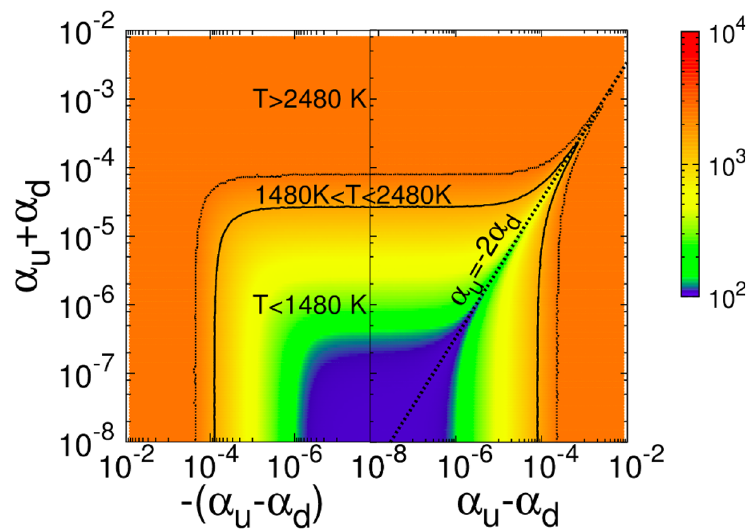
Figure 11 . T obs (in K) in the vector portal DM framework by varying (cid:11) u and (cid:11) d . We (cid:12)x (cid:11) s = 0, (cid:3) = 100 GeV and m (cid:31) = 1 GeV.